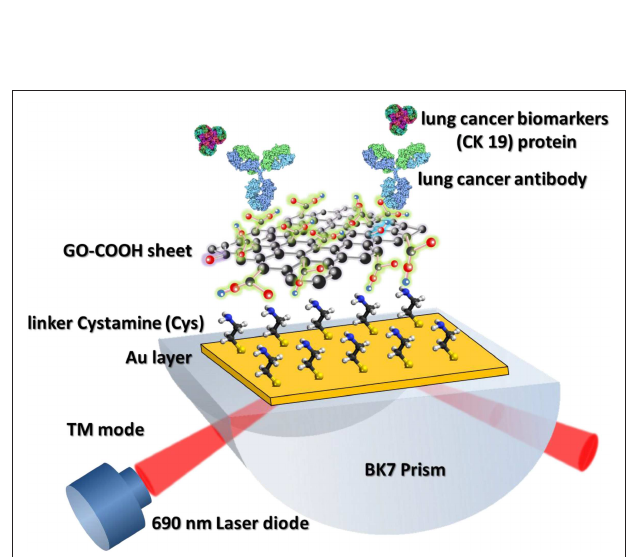
FIGURE 9 | Graphene oxide–COOH sheet-based SPR immunosensor to detect CK19 protein. The figure was reproduced from Chiu et al. (2018) with permission from Elsevier. Copyright 2018,